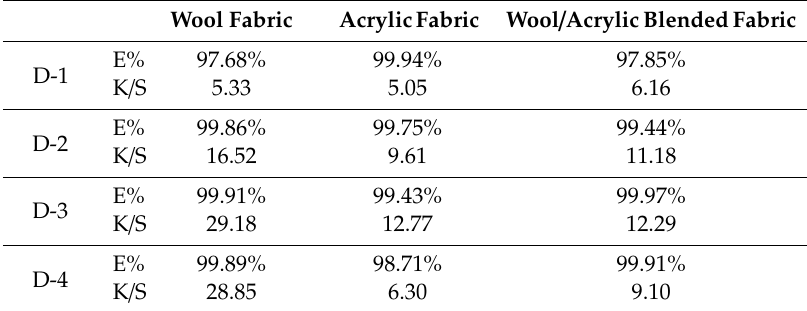
Table 2. Exhaustion and K/S value of synthesized dyes.